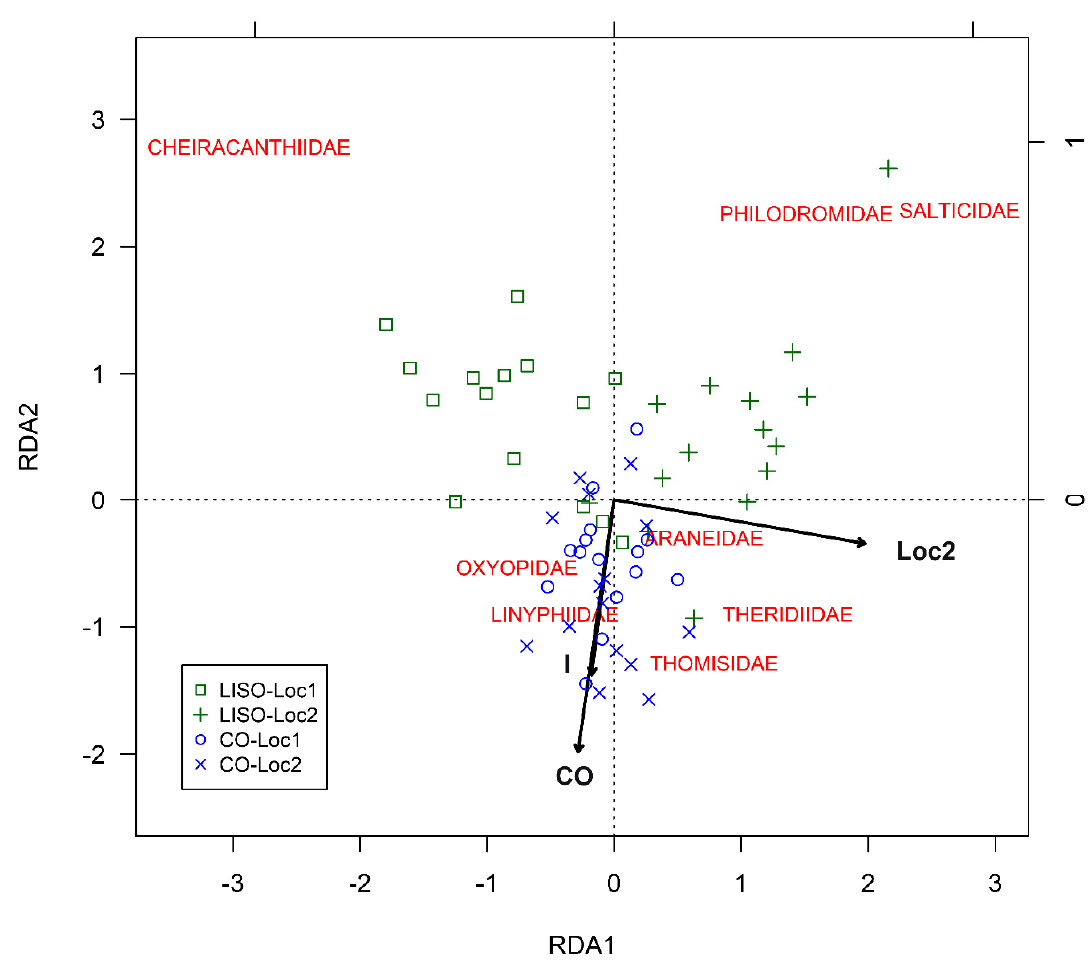
Figure 5. Redundancy analyses (RDA) for the monthly abundance of spider families found in pear orchards as a function of intensity of spraying, locality, and their interaction. RDA1, first constrained ordination axis; RDA2, second constrained axis; LISO, low-intensity spraying orchards; CO, conventional orchards; Loc2, locality 2; I, interaction.